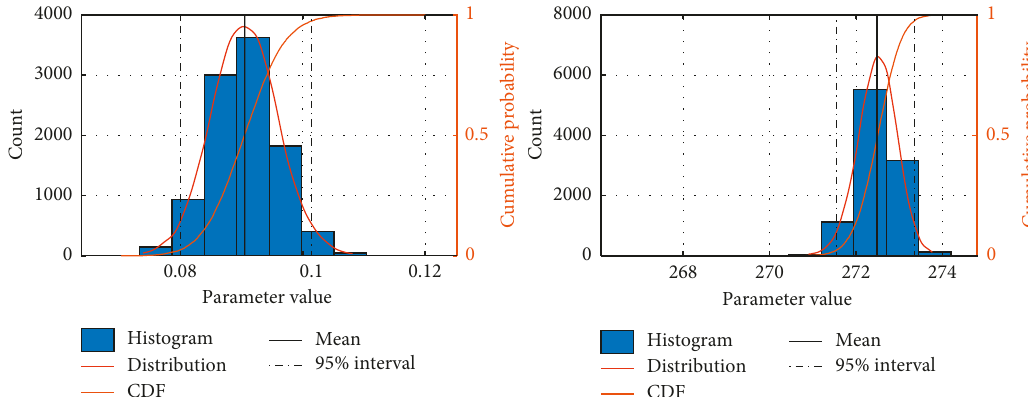
Figure 13: Two examples of the histogram, the distribution and the cumulative probability of the coefficients 􏽥 p confidence interval are indicated.